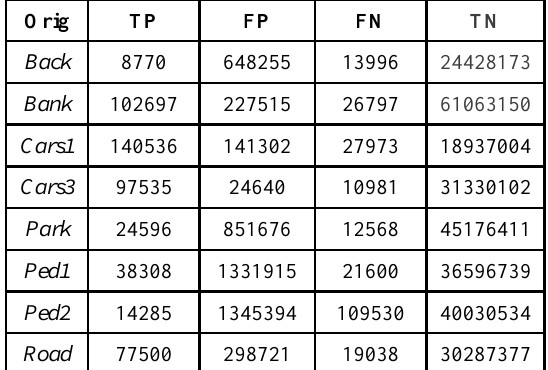
Table 1. Original algorithm results for each video in terms of